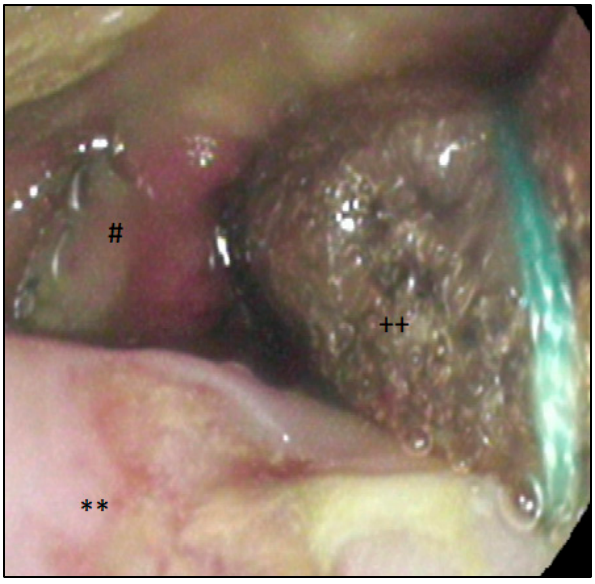
Figure 3. Implanted OFD endoluminal via the anastomosis; **: esophagus; #: anastomosis with exposed clamps; ++: OFD with CNP film wrapped on an enteral feeding tube in position of the EJAL.